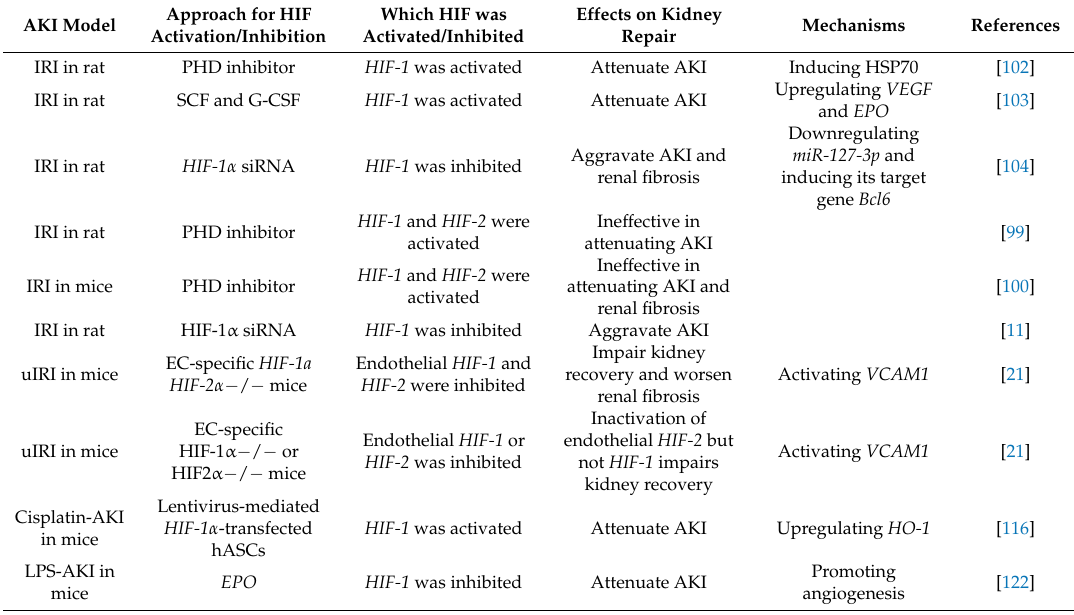
Table 2. Summary of in vivo studies on the effect of HIFs in kidney